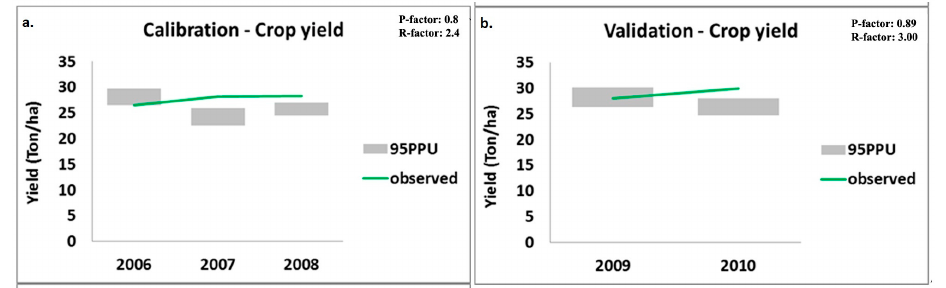
Figure 5. Calibration ( a ) and Validation ( b ) of model for crop yield (rice) based on the average of yield in the selected sub-basins.